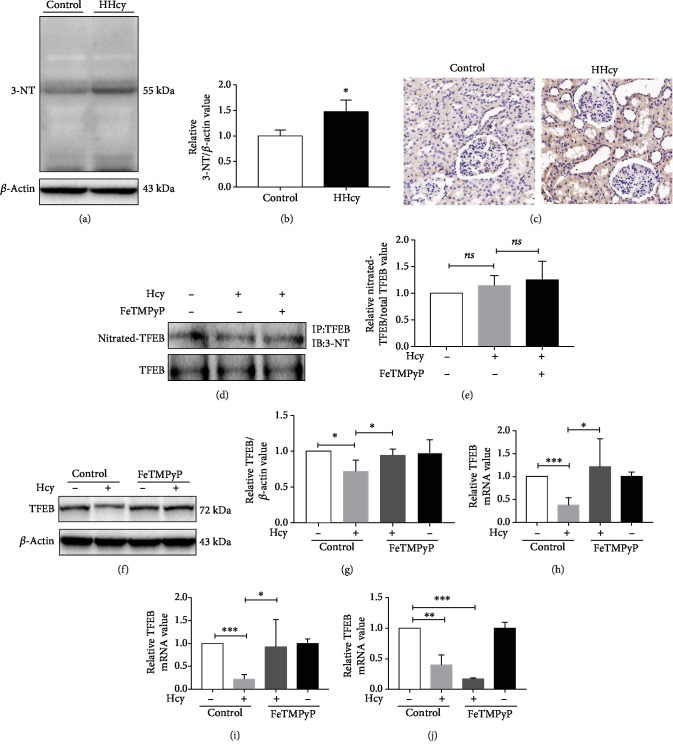
Nitrative stress participated in Hcy-induced TFEB downregulation. (a–c) Representative Western blot and immunohistochemistry detecting 3-NT contents in renal tissue of HHcy rats, respectively. (∗P < 0.05, HHcy vs. Control, n = 4-5). (d) Representative immunoprecipitation showing the contents of nitrated TFEB. Graphs representing (e) quantitative analysis (ns, P > 0.05, Hcy vs. Control, FeTMPyP vs. Hcy, n = 6). (f) Representative Western blot showing the protein expression of TFEB and 3-NT in MPC-5 treated with FeTMPyP. Graphs representing (g) quantitative analysis (∗P < 0.05, Hcy vs. Control, FeTMPyP vs. Hcy, n = 3-4). (h–j) Graphs representing quantitative analysis showing the mRNA level of TFEB in MPC-5 treated with FeTMPyP for 6, 12, and 24 h (∗P < 0.05, ∗∗P < 0.01, and ∗∗∗P < 0.001, Hcy vs. Control, FeTMPyP vs. Hcy, n = 3-4). Control: control group; Hcy: homocysteinemia group. Data were expressed as mean ± SEM.